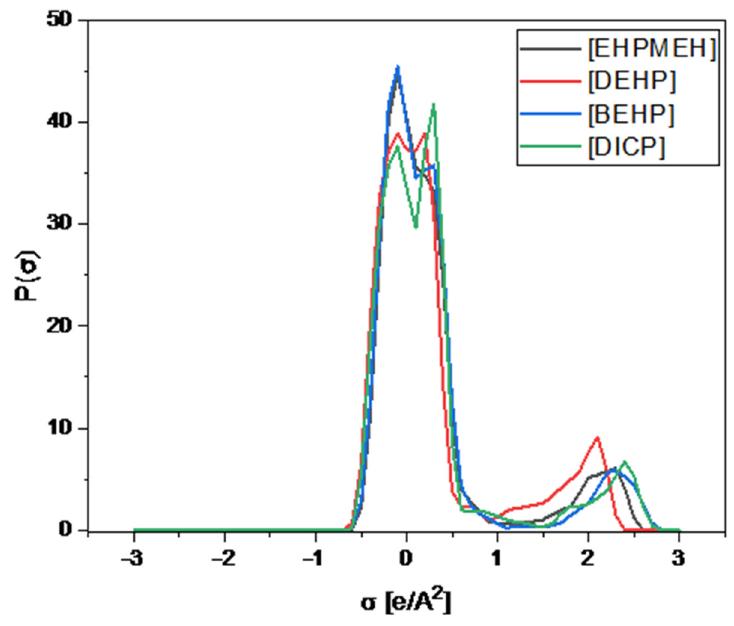
Figure 3. σ -profile of the anions used in the work of Zhao et al. [23].